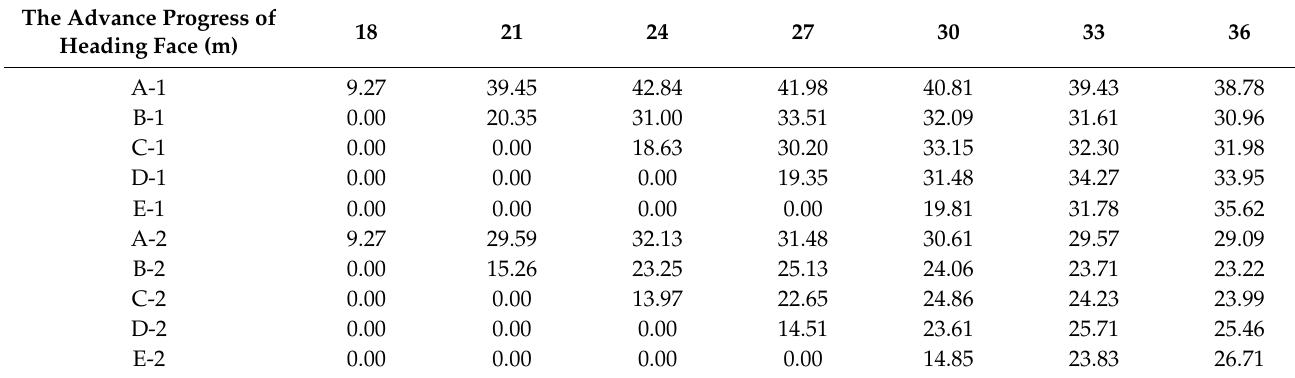
Table 15. Axial force trend of secondary lining arch crown (Unit: